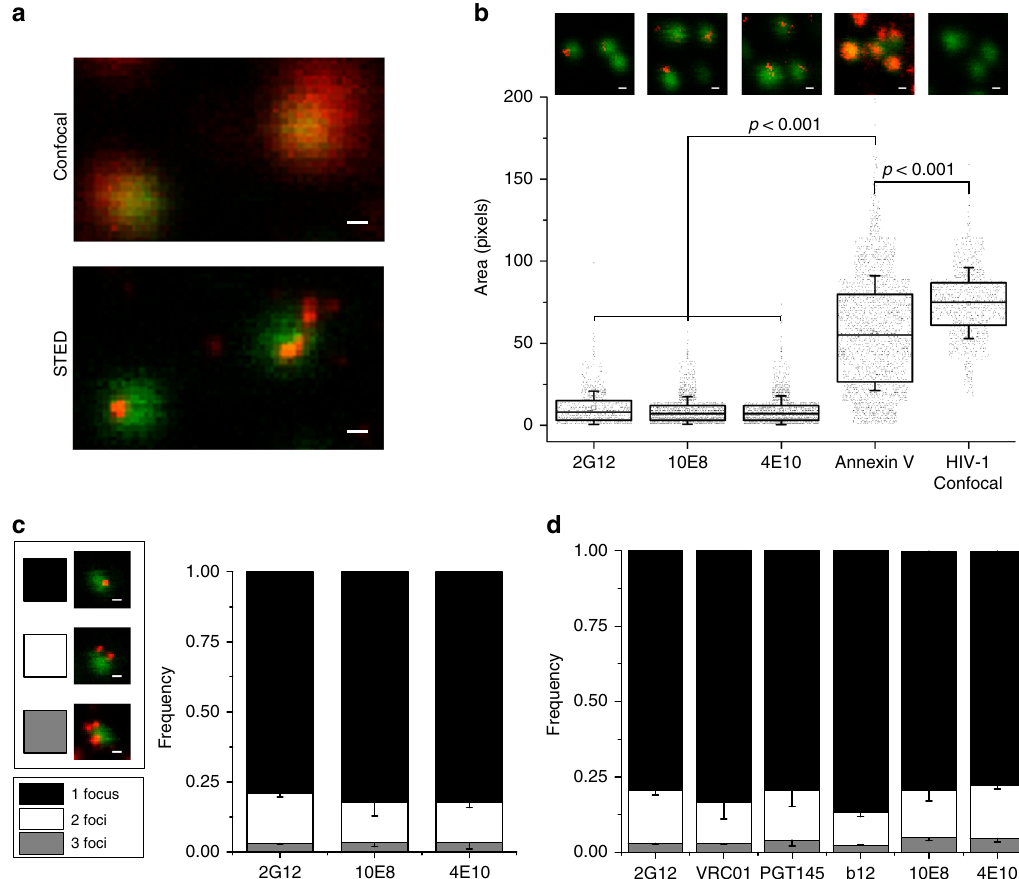
Fig. 2 Accessibility of MPER Env site on intact HIV virions visualized by super-resolution STED microscopy. a Signal of 10E8-KK114 (red) bound to HIV-1 virions acquired in confocal (top) or STED modes (bottom). In both images virions are visualized in confocal mode (green, Vpr.eGFP). b STED micrographs of 2G12 (stained with secondary antibody), 10E8-KK114, 4E10-KK114, and Annexin V-ATTO 647 (STED, red) bound to HIV-1 virions (top) and corresponding pixel areas (bottom). Results are shown in a box-plot (center line, median; square, mean; box, interquartile range (IQR); whiskers, s.d.) of STED (2G12, n = 756; 10E8, n = 1693, 4E10, n = 1575; and Annexin V, n = 2136) and confocal (Vpr.eGFP, n = 942) signals measured in single virions from three independent preparations. Pixel size is 20 nm/pixel. The statistical signi fi cance was assessed by Kruskal – Wallis one-way analysis of variance. c Representative images of HIV virions incubated with 10E8-KK114 (left) and distribution analysis of Fab STED foci number (right) upon incubation with 2G12 (stained with secondary anti-human Fab-KK114) or directly labeled 10E8 and 4E10 Fab-KK114 conjugates. d Distribution of Fab STED foci detected on virions. Bound Fabs were revealed in this case by secondary staining (anti-human Fab-KK114). Error bars are s.d. of at least three independent experiments. Scale bars are 100